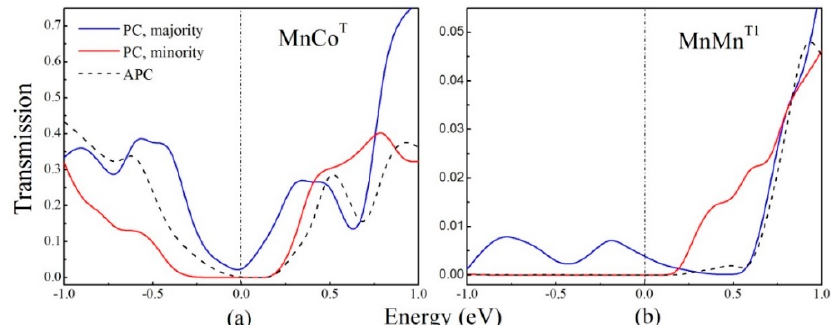
Figure 8. Transmission coefficient versus electron energy in PC (parallel configuration) and APC (anti-parallel configuration) of the Mn 2 CoAl/Ag/Mn 2 CoAl CPP-SV at equilibrium; ( a ) The structure with MnCo T -termination; ( b ) The structure with MnMn T1 -termination .